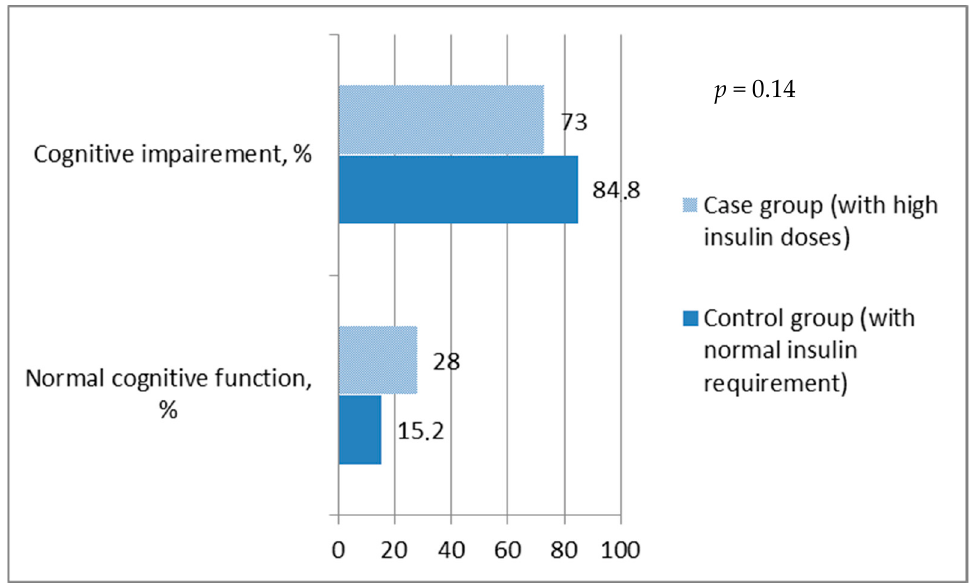
Figure 1. Prevalence of impaired cognitive function in T2DM groups with different exogenous insulin doses.